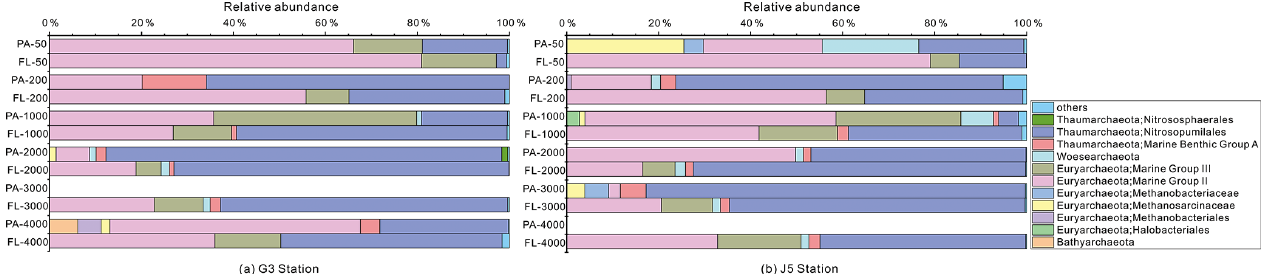
Figure 7. Taxonomic compositions of particle-attached and free-living archaeal communities of seawaters at different depths along two different water columns in the South China Sea. (a) G3 station; (b) J5 station. PA-3000 at the G3 station and PA-4000 at the J5 station indicate the samples failing in the sequencing of archaeal 16S rRNA gene. The archaeal lineages, at the phylum or class level, with less than 1% proportions are classified into “others” (Fig.